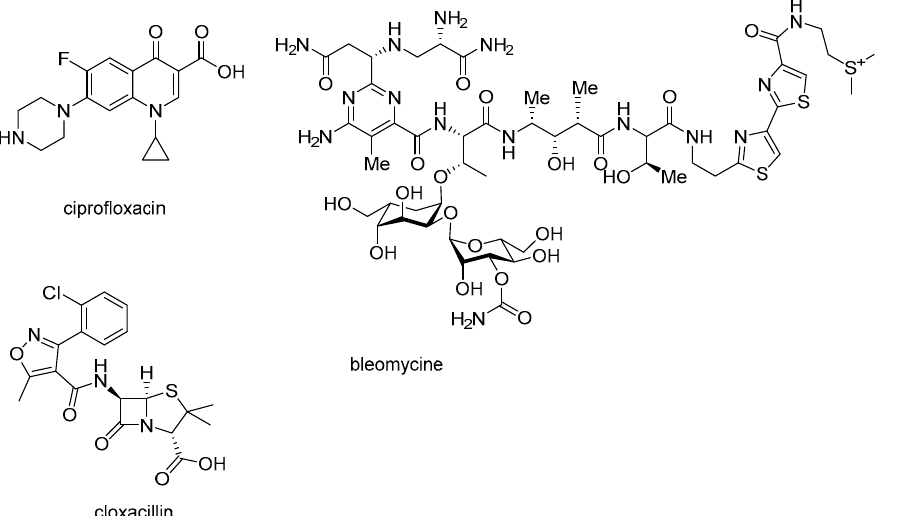
Figure 8. The structure of antibiotics ciprofloxacin, bleomycin, and cloxacillin used as reference compounds.